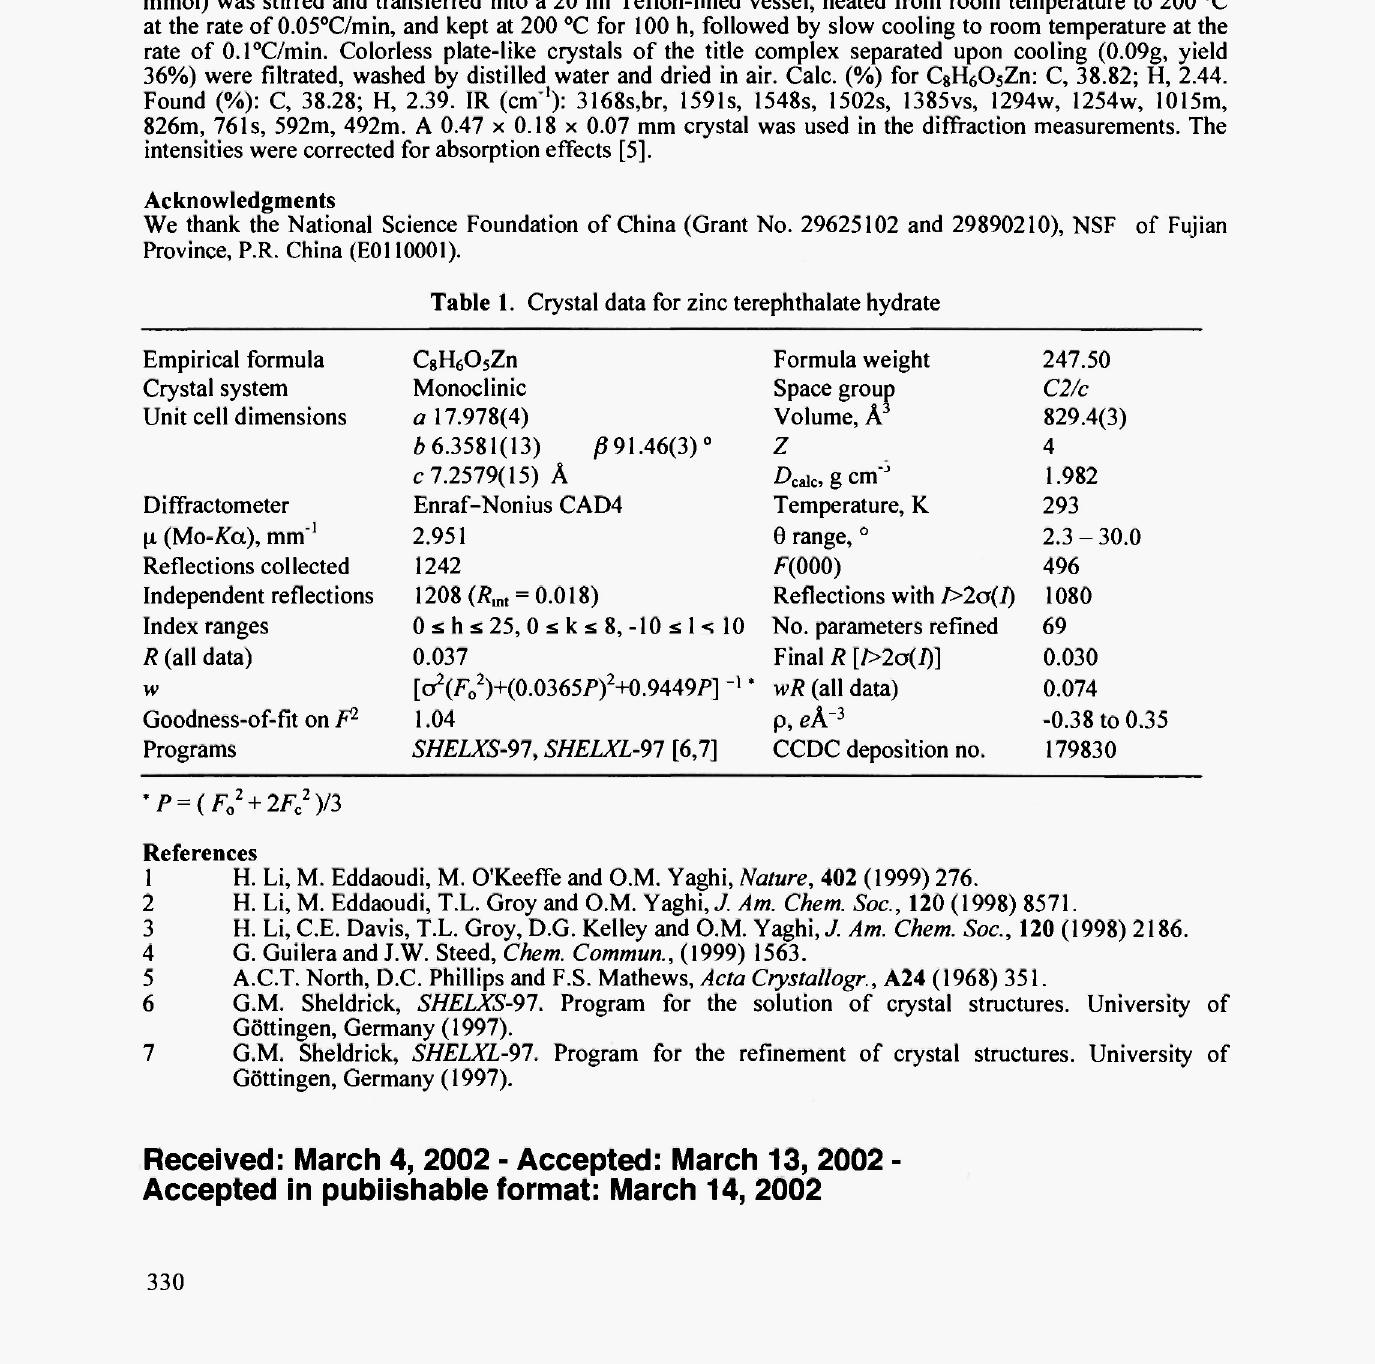
Table 1 . Crystal data for zinc terephthalate